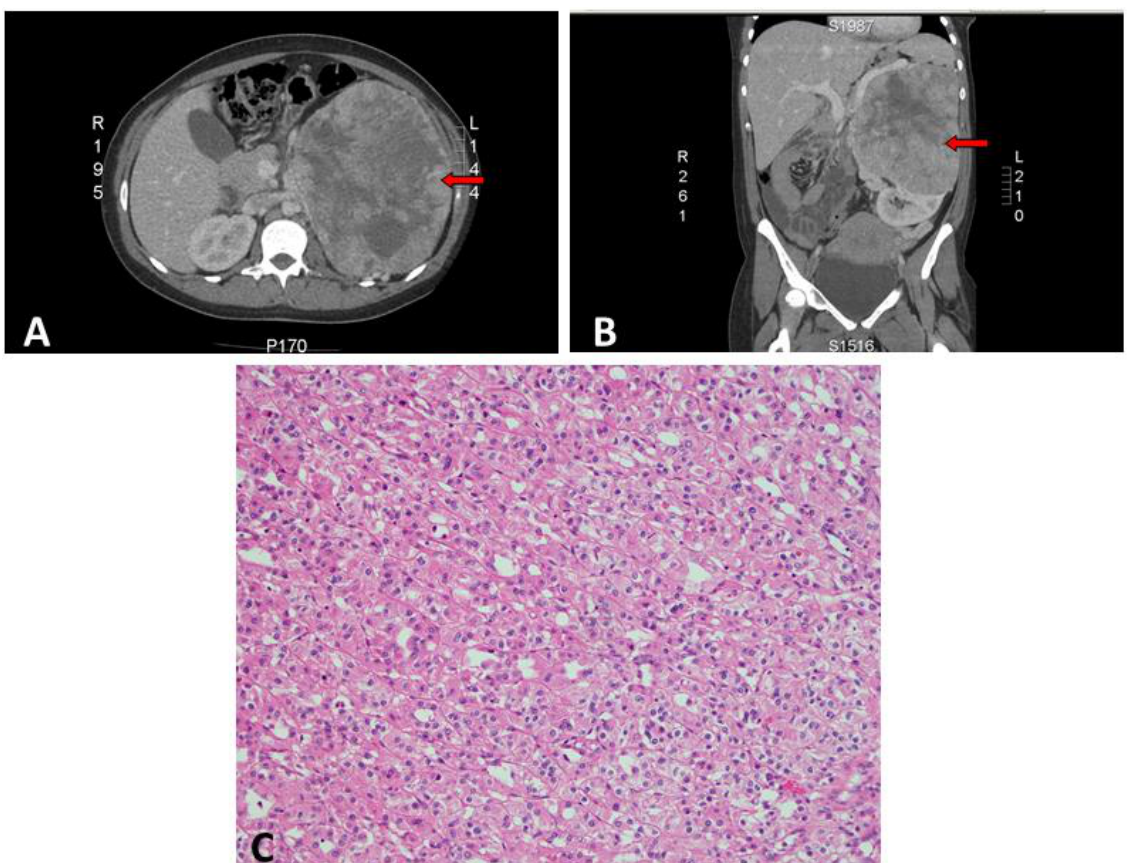
Figure 1: Computed tomography of abdomen and the histology of RCC. A, Axial CT scan of left renal tumor occupying almost half of the abdomen (arrow). B, Coronal CT scan view of left renal tumor at the upper pole displacing the normal lower pole renal parenchyma (arrow). C, Hematoxylin and Eosin staining of the tumor showed chomophobe morphology with peri-nuclear halo and transitional